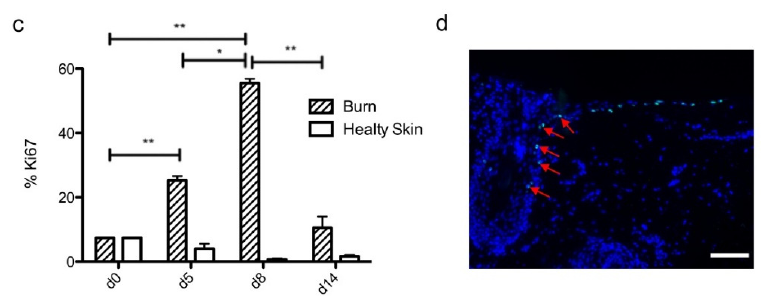
Figure 4. Kinetics of re-epithelialization from day 8 onward in ex vivo cultured human skin explants submitted to 10 s long experimental burn injury. Following a 10 s long experimental burn performed on ex vivo cultured human skin explants, the kinetics of re-epithelialization was assessed by HPS staining ( a ) and immunostaining of the proliferation marker Ki67 ( b – d ). ( a ) Wound closure was operated by proliferating keratinocytes which migrated from the wound edges and then formed an epidermal tongue on d5, before covering the whole lesioned area on day 8. A complete differentiation of the epidermis up to the formation of the superficial layers, including the stratum corneum, was then observed on day 14. ( b , c ) The keratinocyte proliferation index (ratio of proliferating Ki67 + cells relative to the total number of epidermal cells) was measured in human skin explants harvested at different time points of the culture. For each donor ( n = 3) and for each time point, measurements were carried out on both edges of the lesion and expressed as mean values. On day 5 post burn, proliferating basal keratinocytes were only observed in the epidermal tongue, close to the wound margins. In this area, the keratinocyte proliferation index more than doubled as compared to the proliferation index observed in day 0 (control) skin explants ( c ). A peak in keratinocyte proliferation index was observed on day 8/9 with 55% of proliferating cells in the edges of the re-epithelialized lesion. Interestingly, several layers of Ki67 + epidermal cells were observed at this stage. Finally, on day 14 post burn, the keratinocyte index reached a mean of 10%, close to that observed in the epidermis of day 0 (control) skin explants (6%). ( d ) Demonstration of proliferating cells within the dermis in close vicinity to a hair follicle at the edge of the lesioned area (red arrows). Dashed lines in black ( a ) or white ( b ) delineate the burnt area from the adjacent non-lesioned skin areas. Statistical significance was assessed with the paired t -test. * p < 0.05, ** p < 0.01. Scale bar: 100 µm.